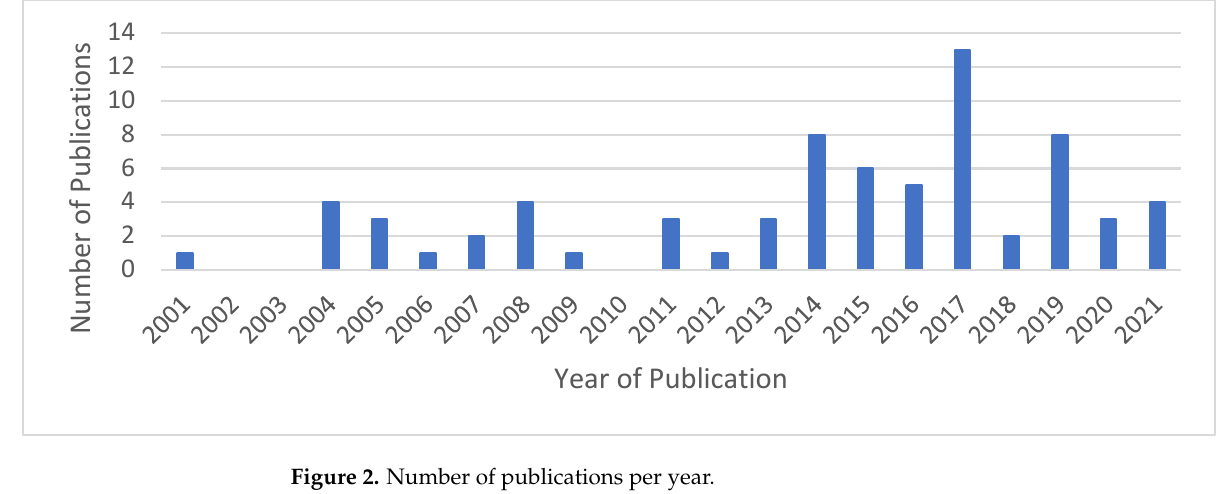
Figure 2. Number of publications per year.